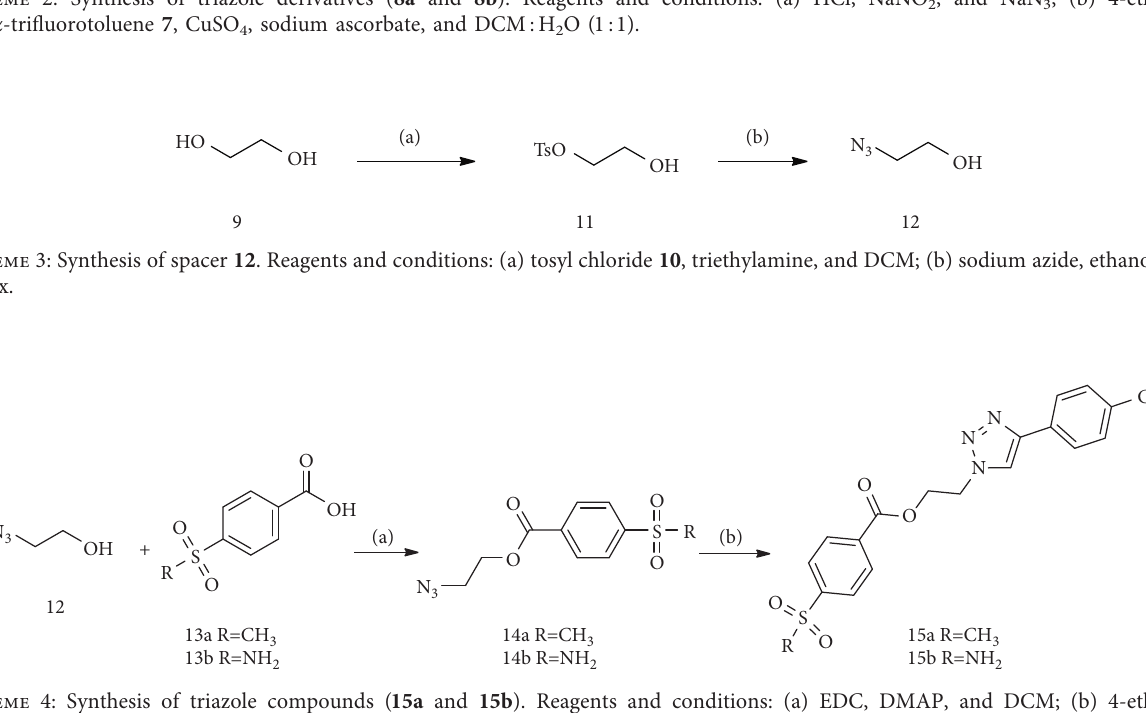
2 , and NaN 3 ; (b) 4-ethynyl-